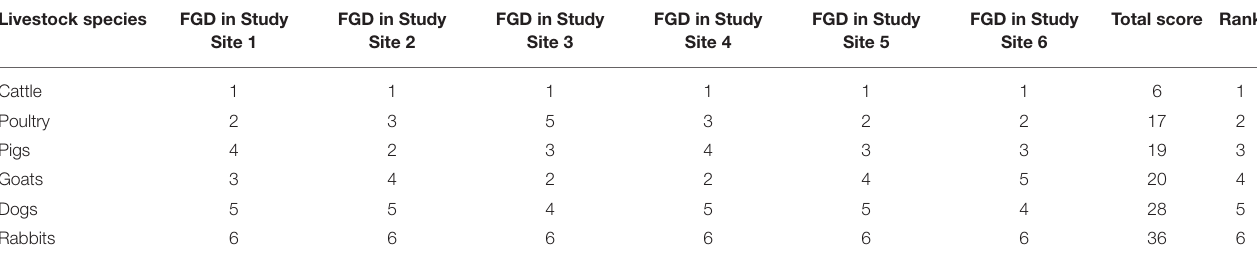
TABLE 1 | Simple ranking based on the economic importance of the domestic animals discussed among community members in Masaka district, Uganda. Livestock